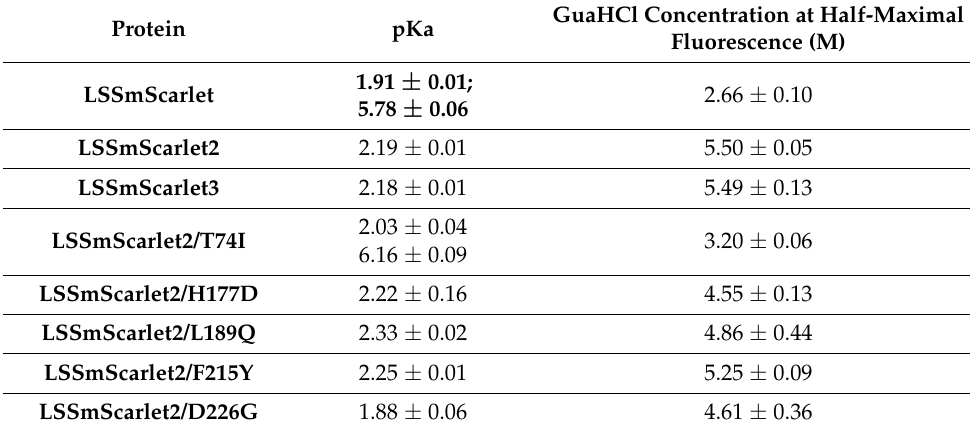
Table 3. pH stability and chemical stability of LSSmScarlet, LSSmScarlet2, LSSmScarlet3 (LSSmScar- let2/G170D), and LSSmScarlet2 mutants in guanidinium